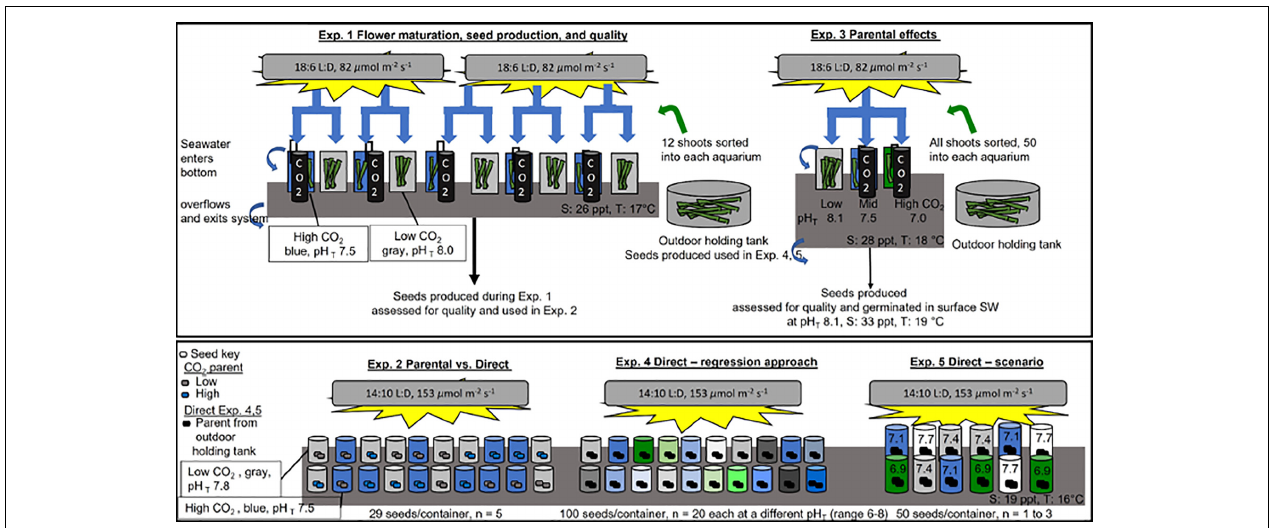
FIGURE 1 | Schematic of experimental design for experiments (Exp.) 1–5. See Table 1 and see section “Materials and Methods” for more information. Exp 1 and 3 (top box) were done at Kristineberg Marine Research Station under a light bank, within a flow through system where surface supplied seawater (SW) entered the bottom of the containers, over flowed and exited the system (water flow shown by blue arrows). Flowering shoots of Zostera marina were collected on 17 July 2017 (Exp 1) and 9 August 2019 (Exp 3) near the station. Shoots were held overnight in an outdoor holding tank and then immediately sorted into replicate containers. Containers were held at appropriate CO 2 treatments with a controller that sensed pH (black line) and regulated bubbling of CO 2 (black cylinders) into seawater. Exps. 2, 4, and 5 (bottom box) were done at Dauphin Island Sea Lab in closed system placed within a cold room (16 C), under a light bank. SW at appropriate treatment levels was replaced in containers every 1–2